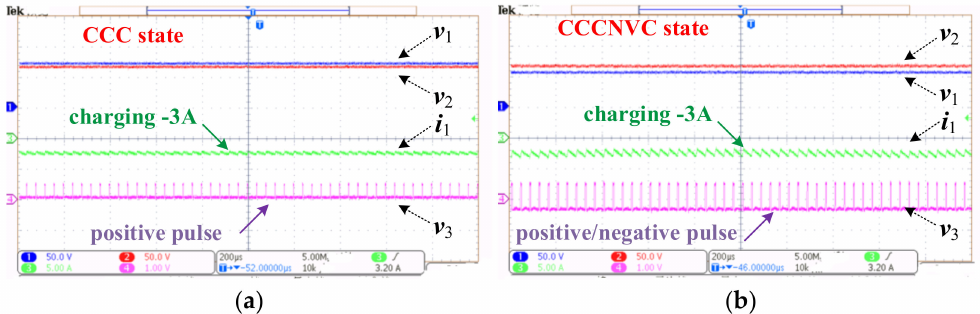
Figure 13. Waveforms during charging process: ( a ) CCC state; and ( b ) CCC-NVC state.